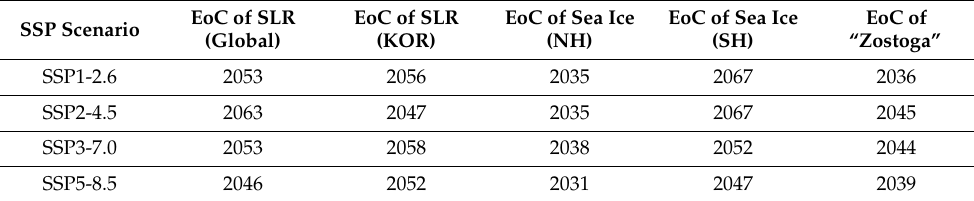
Table 2. EoC values from CMIP6 ensemble based on each SSP